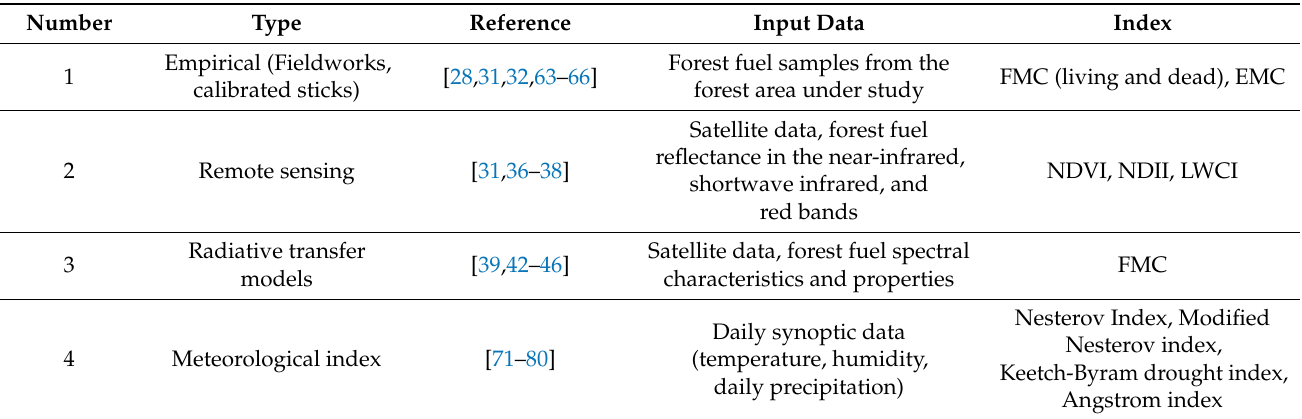
Table 1. Research on forest fuel